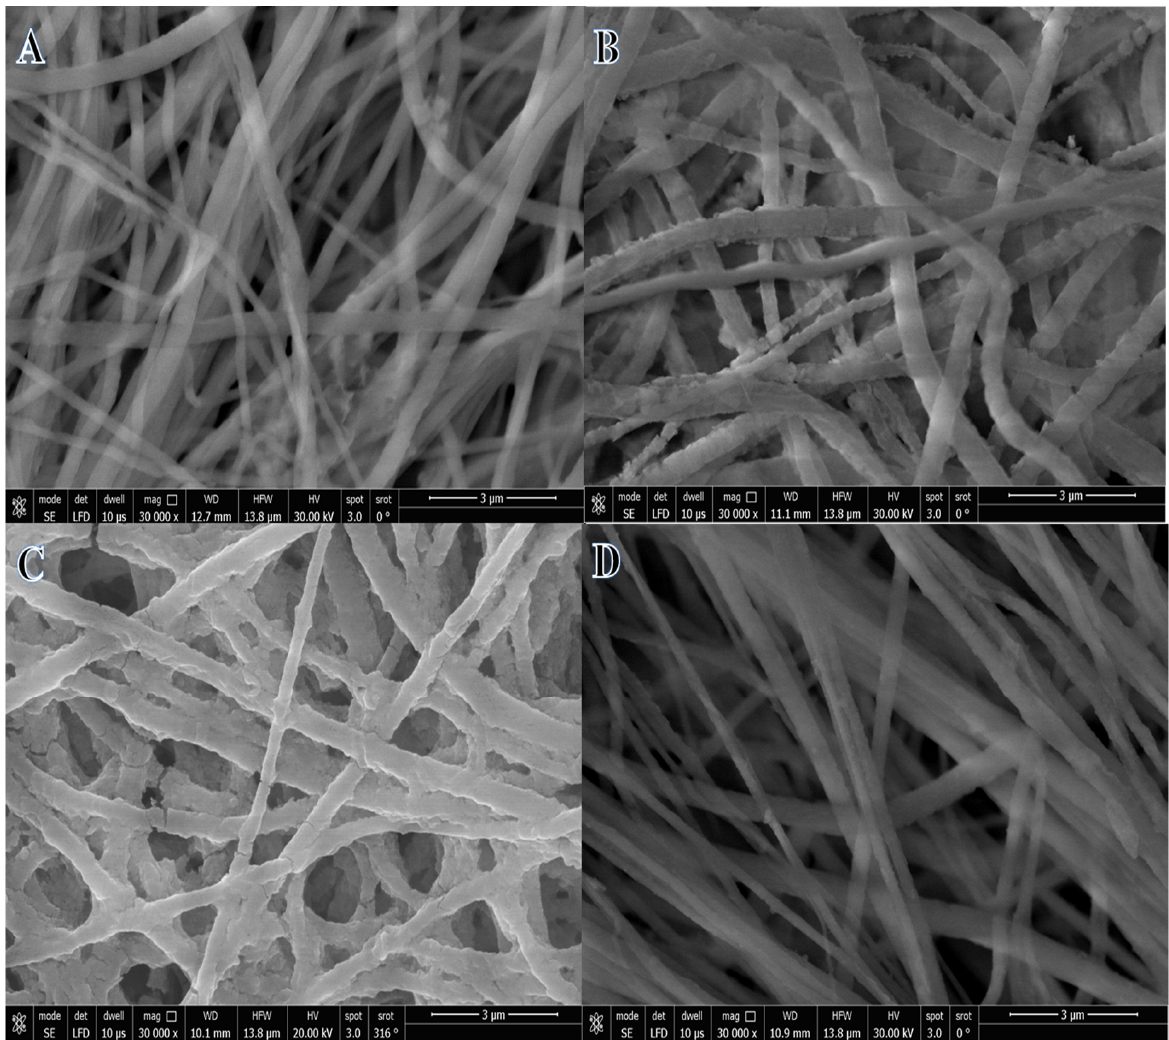
Figure 1. SEM images of PVDF ‐ co ‐ HFP ( A ), Ni@PVDF ‐ co ‐ HFP ( B ), Ni 0.3 Co 0.7 @PVDF ‐ co ‐ HFP ( C ), and Co@PVDF ‐ co ‐ HFP ( D ).